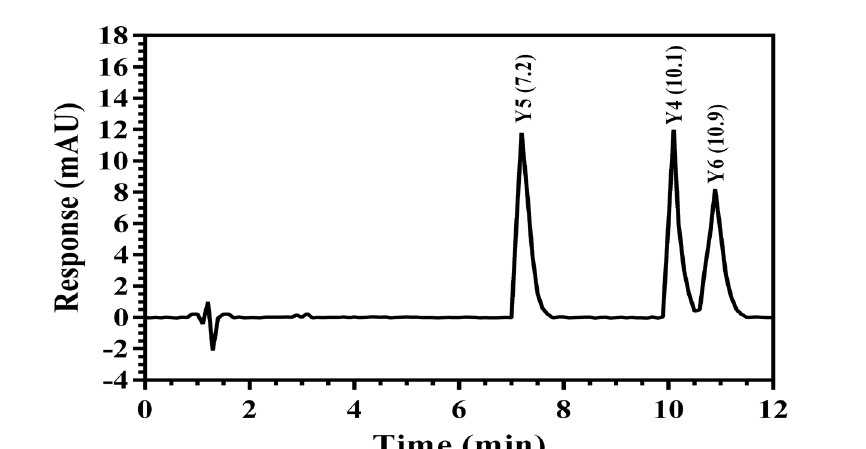
FIGURE 2 - Representative chromatogram of RSG (Y4), N-Dm-R (Y5), and p-OH-R (Y6). Chromatographic conditions: column